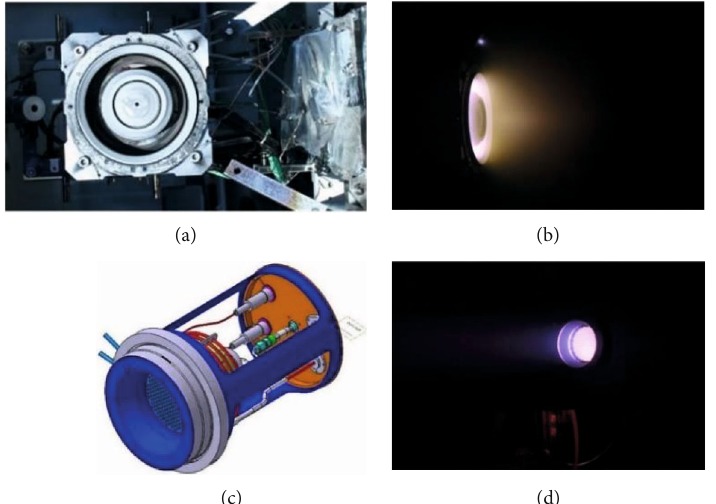
Figure 14: Two tests on HET and RIT: (a) the PPS1350-TSD; (b) HET operating with N thruster; (d) RIT-10 thruster running with N